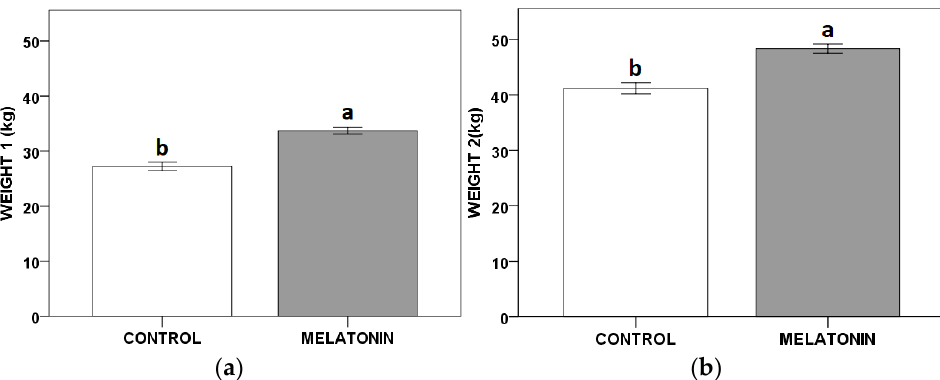
Figure 1. Effect of melatonin implants on the calves’ weights registered at two fixed dates (Weight 1 calf ( a ) July; Weight 2 calf ( b ) at weaning, August) in yearling Iberian red deer hinds ( Cervus elaphus hispanicus ). Melatonin: the yearling hinds received melatonin implants, administered three-fold (two implants each time) every 30 days before the breeding season; Control: the yearling hinds received no melatonin treatment. Different letters show significant differences ( p < 0.05) between the experimental groups.